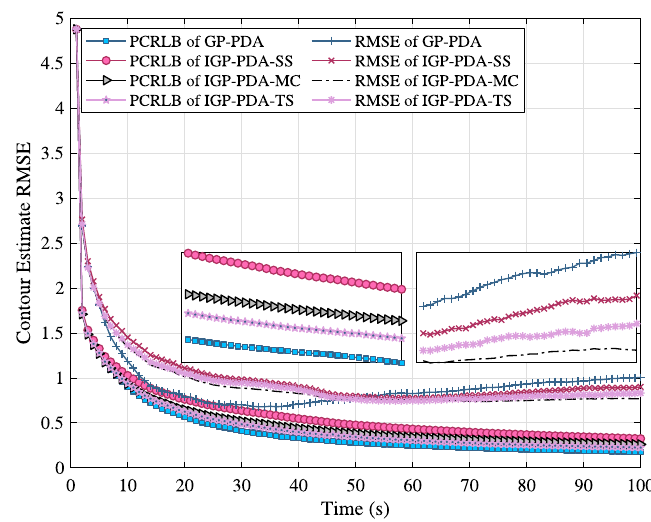
Fig. 5 Contour estimates: RMSE versus PCRLB in the first